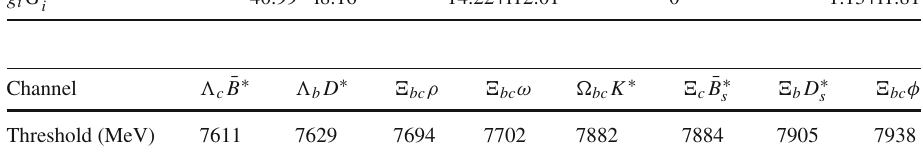
Table 21 Coupling constants to various channels and g i G II MeV with q max = 650MeV